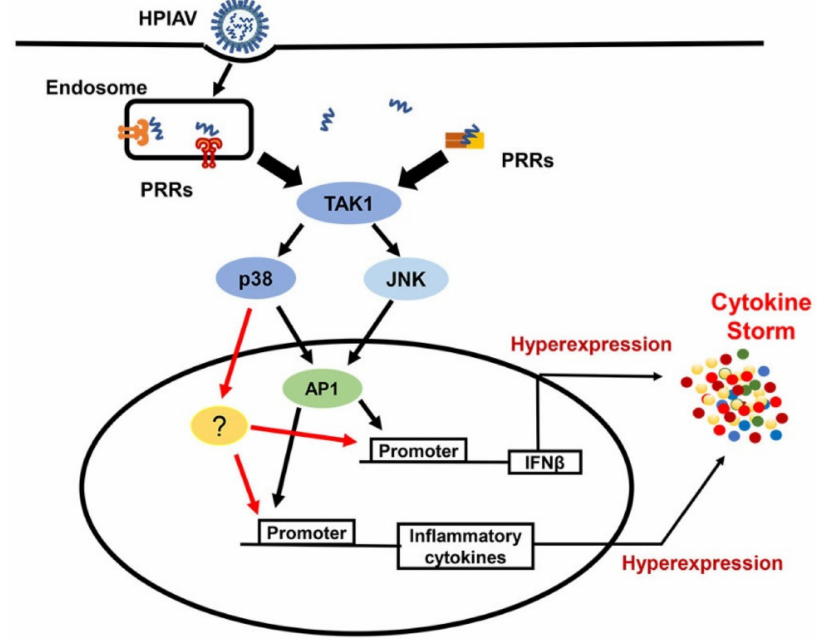
Figure 1. Pivotal Role of Mitogen-Activated Protein Kinases (MAPKs) in cytokine storm induced by highly pathogenic influenza virus infection. In response to infection by highly pathogenic influenza viruses (HPIAVs) such as H5N1 infection, PRRs, including RIG-I and TLR7 signalling, activates MAPKs, including JNK and p38, through TAK1. JNK activation contributes to hyper-expression of IFN β and other inflammatory cytokines via transcription factor AP-1. p38, on the other hand, regulates more than 90% of inflammatory cytokine genes through AP-1 and other unknown